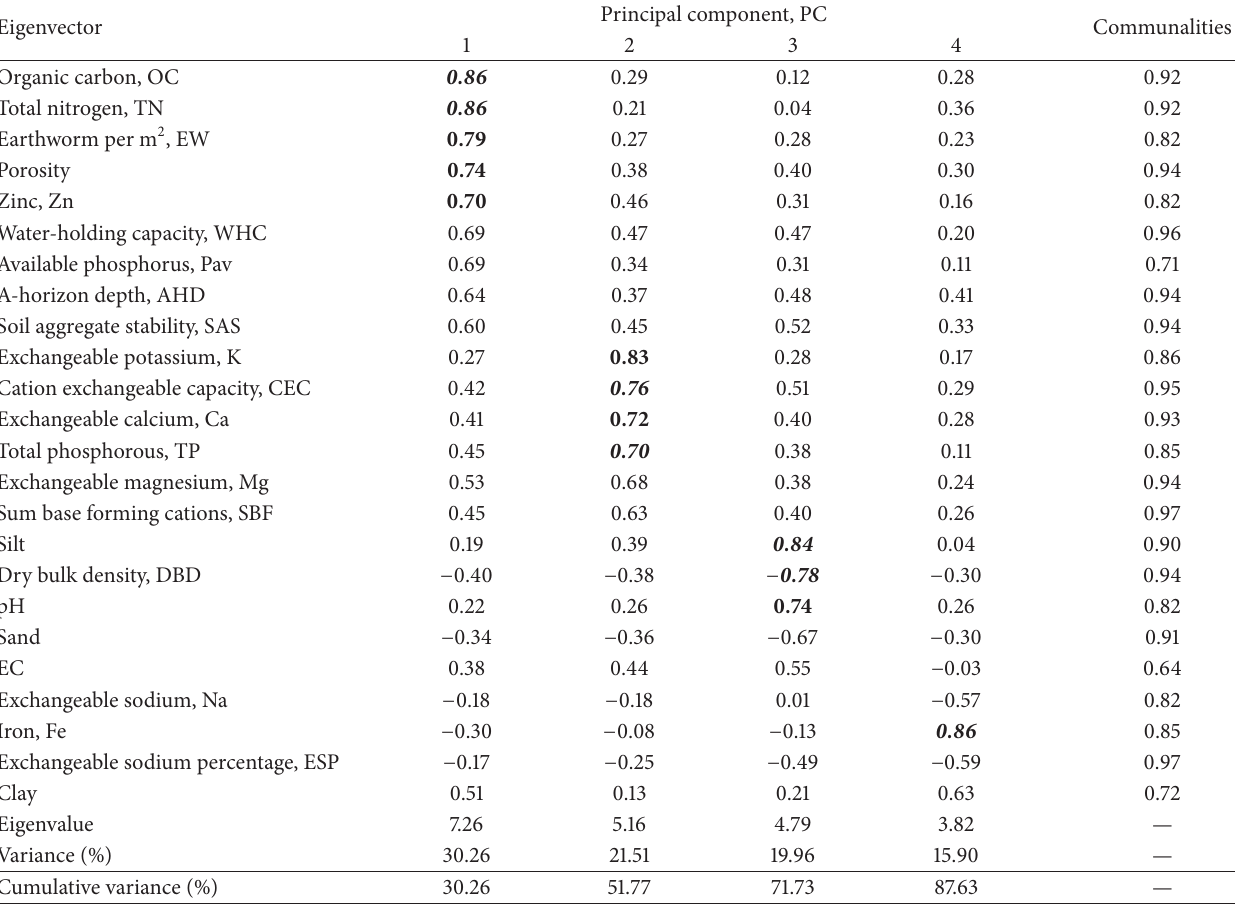
Boldface eigenvector values correspond to the PCs highly weighted variables examined for the index. Bold-italic factors correspond to the indicators retained in the SQ index. The weight of the variables included in the index was decided using the variance